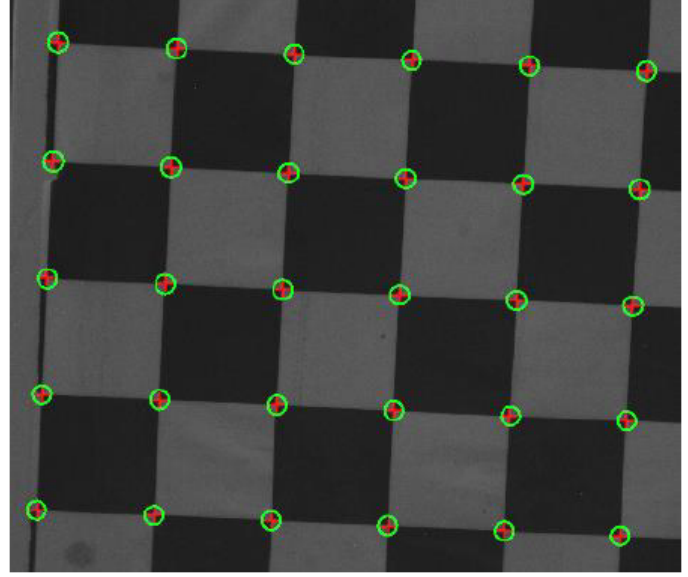
Figure 2. Some corners extracted by Harris